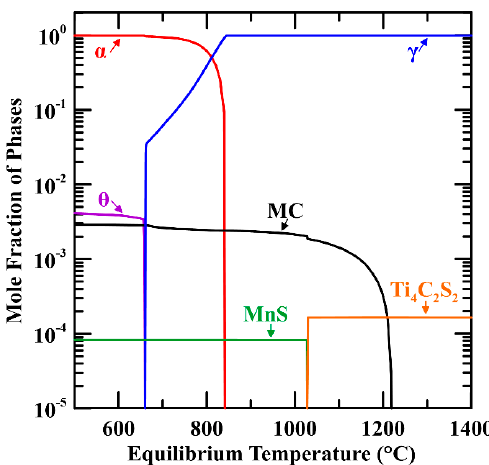
Figure 3. Evolution of equilibrium phases as a function of temperature predicted with Thermo-Calc ® using the TCFE9 database. It was assumed that all N was first incorporated into TiN precipitates at much higher temperatures (greater than 1500 °C).